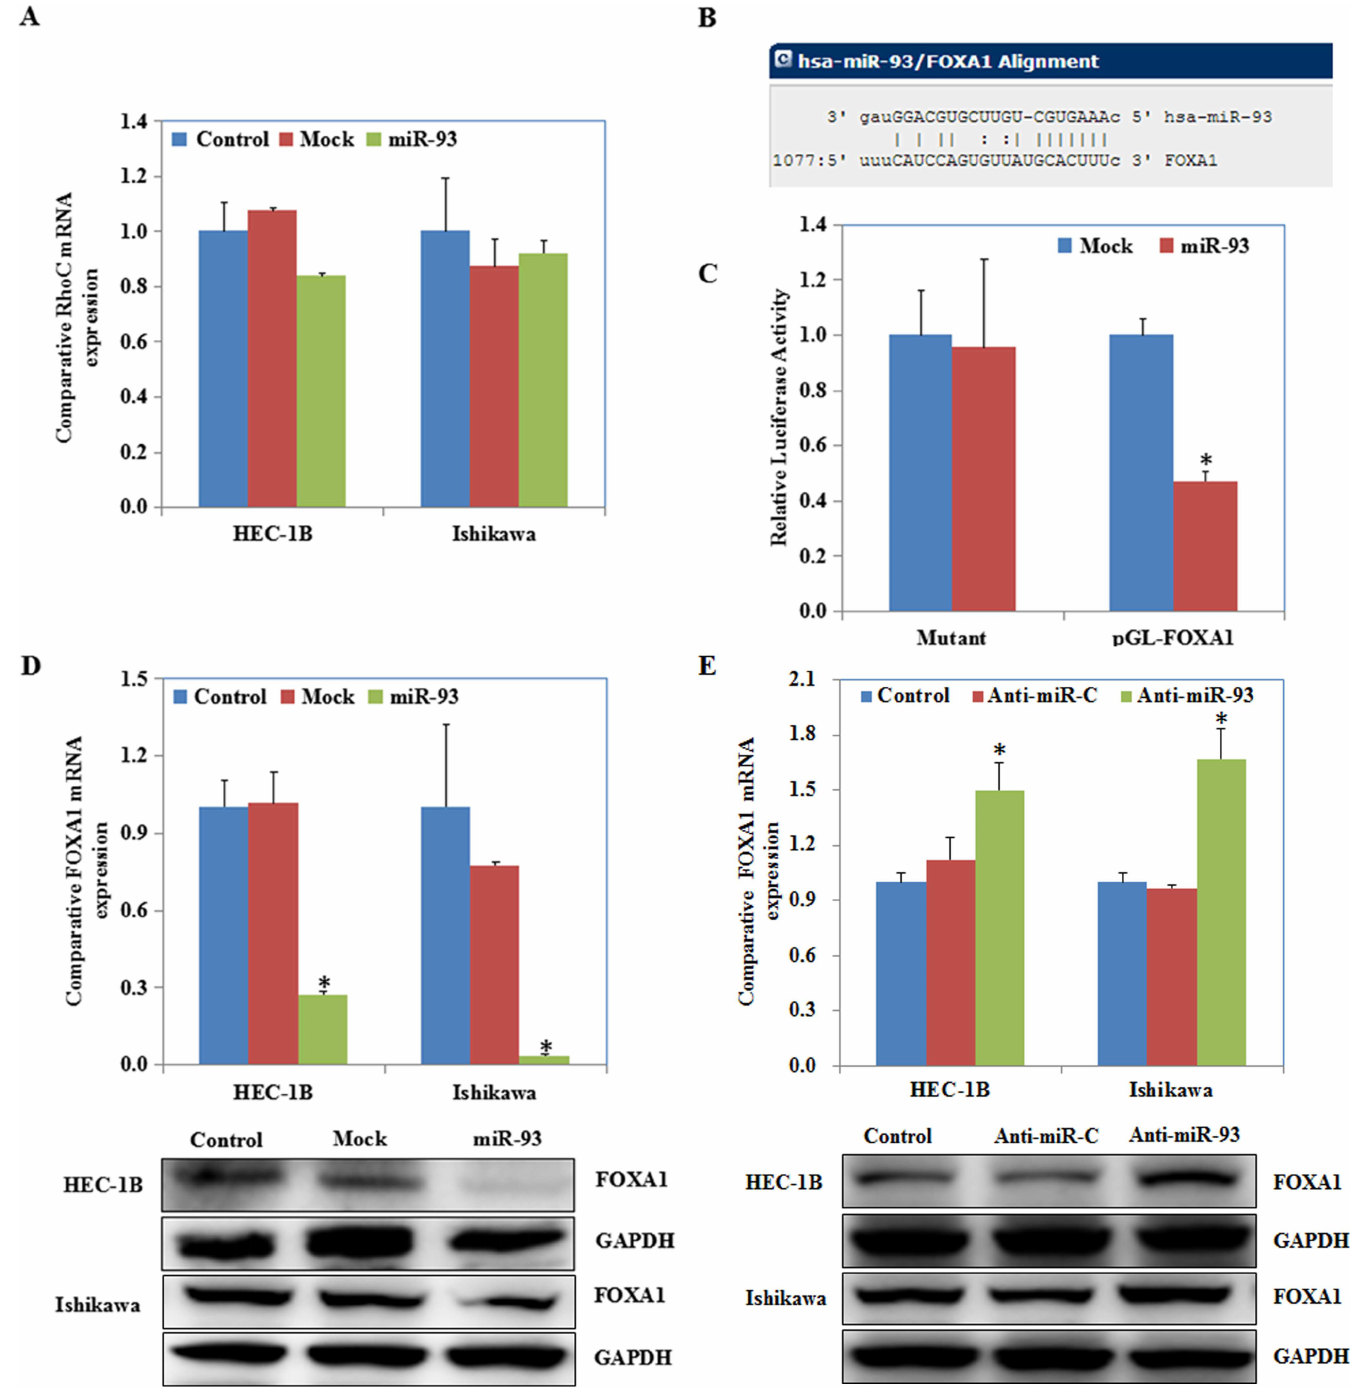
Fig 4. MiR-93 transfection downregulated expression of FOXA1. After miR-93 transfectionthe expression of RhoC had no significantdifferences (A) but FOXA1 was downregulated (D). According to a predictionwebsite and Luciferasereporter assays demonstrated miR-93 could targets the 3’UTR of FOXA1 directly (B & C). MiR-93 inhibitor transfection inducedFOXA1 expression(E).